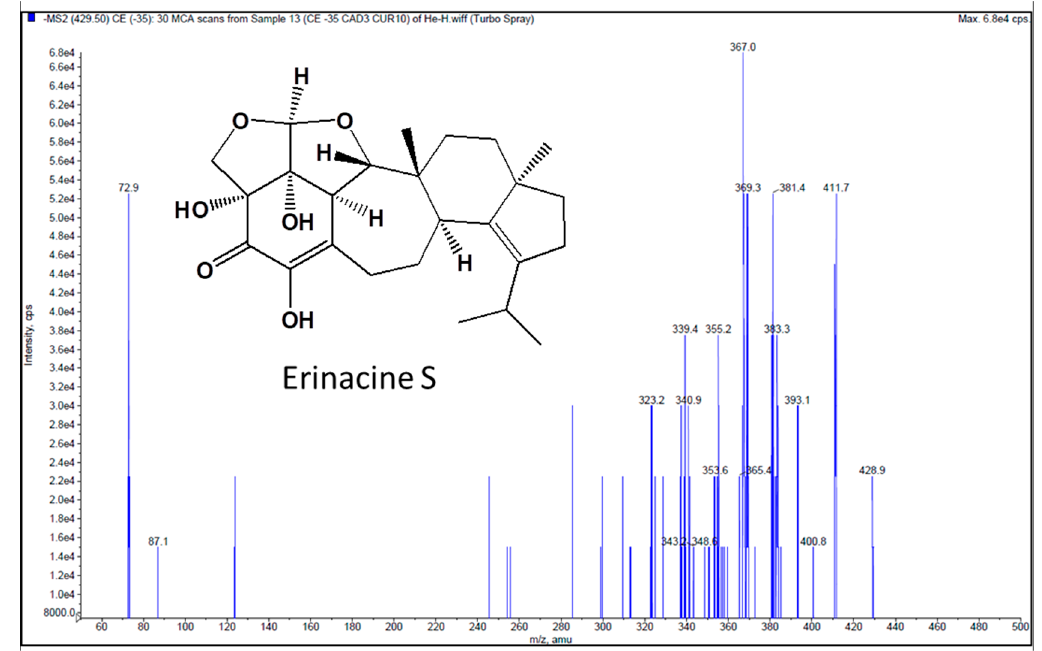
Figure 1. Product ion spectrum of Erinacine S.